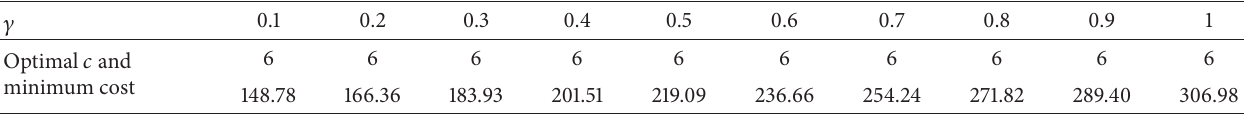
Table 2: Optimal server 𝑐 and minimum cost.